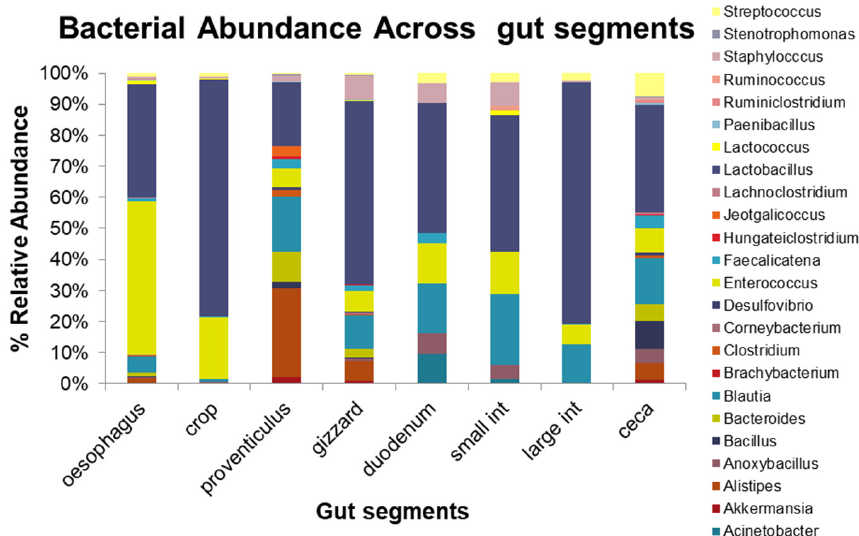
Figure 4. Stacked bar graph showing the relative abundance of the gut bacterial communities across the different gut segments.